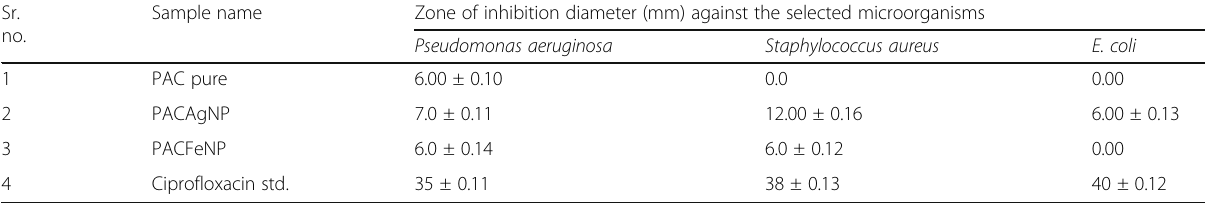
Table 1 Results of antibacterial activity of PAC, PACAgNP, and PACFeNP against selected microbial strains Sr.